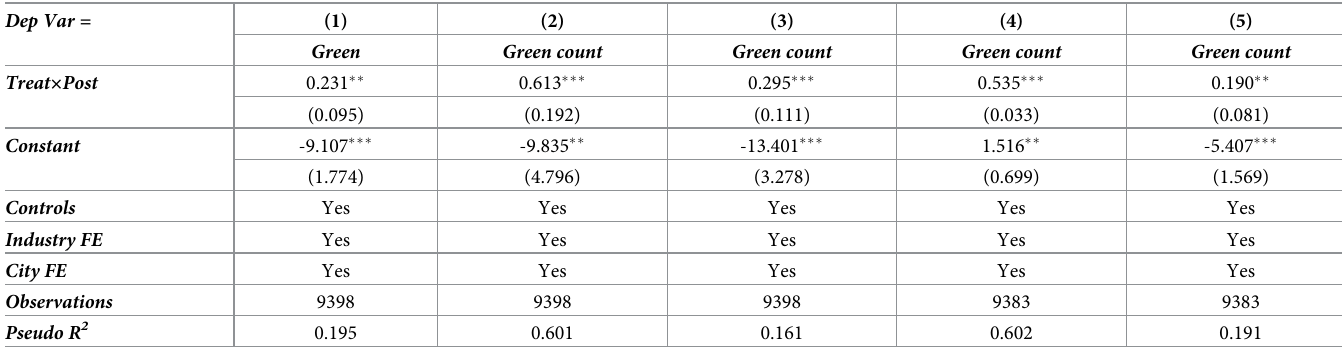
Table 5. Robust regression results for Poisson and Negative Binomial model.